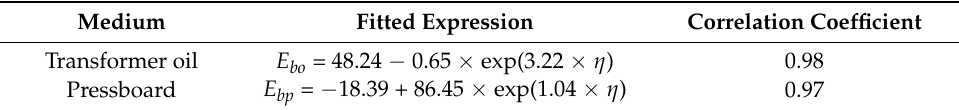
Table 3. Fitted Expressions for Breakdown Strength.